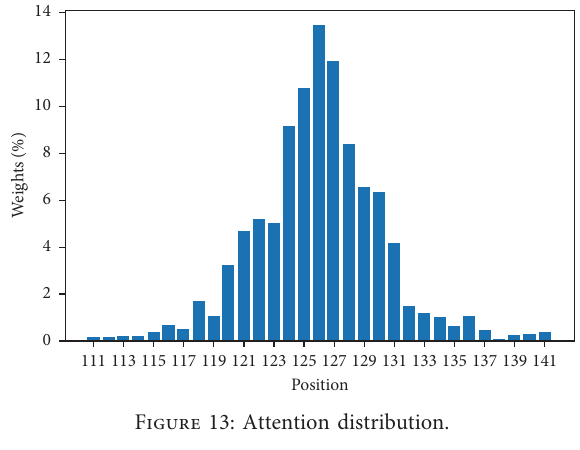
Figure 13: Attention distribution.